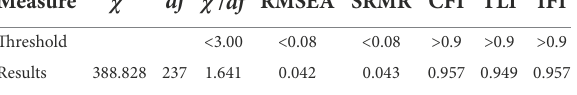
TABLE 5 Confirmatory factor analysis.